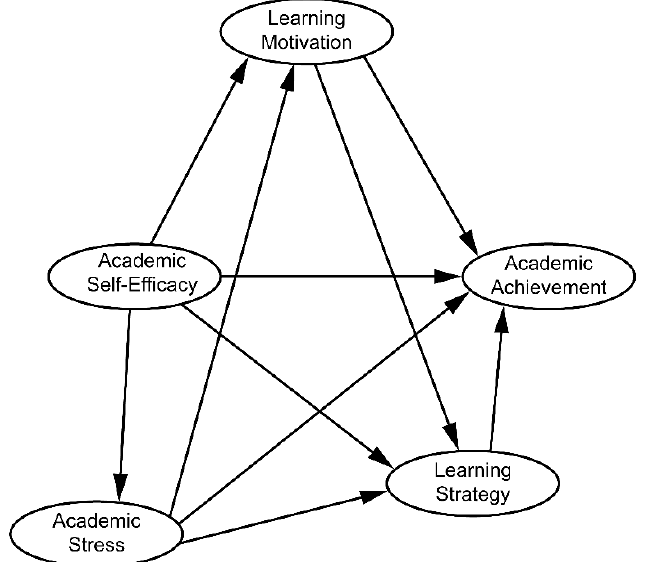
Figure 1. Hypothetical research model showing academic stress, learning motivation, and learning strategy as mediating variables in the relationship between academic self-efficacy and academic achievement.